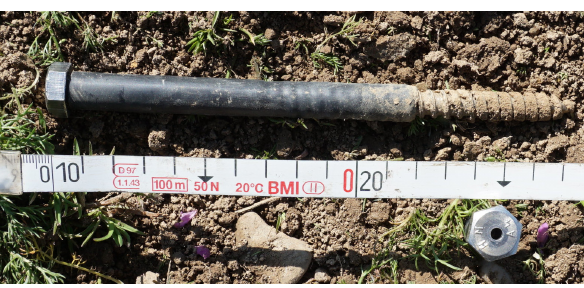
Figure 3. Stainless-steel electrode used for sEIT measurements. Scale is in centimetres.